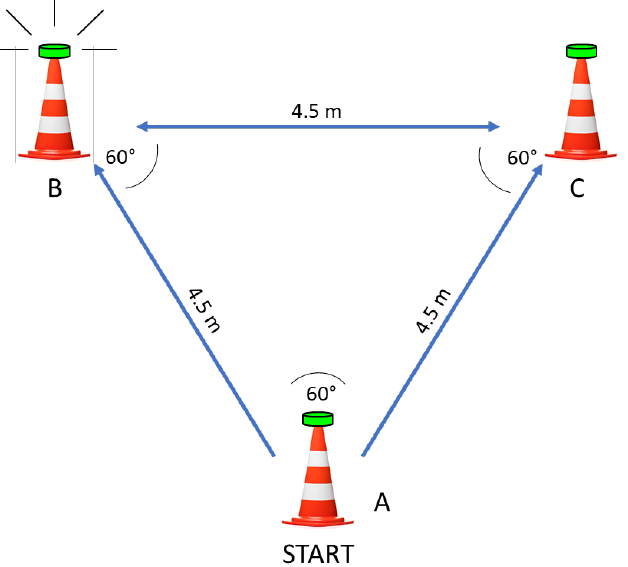
Figure 1. Scheme of the TRAG and TCODS testing.